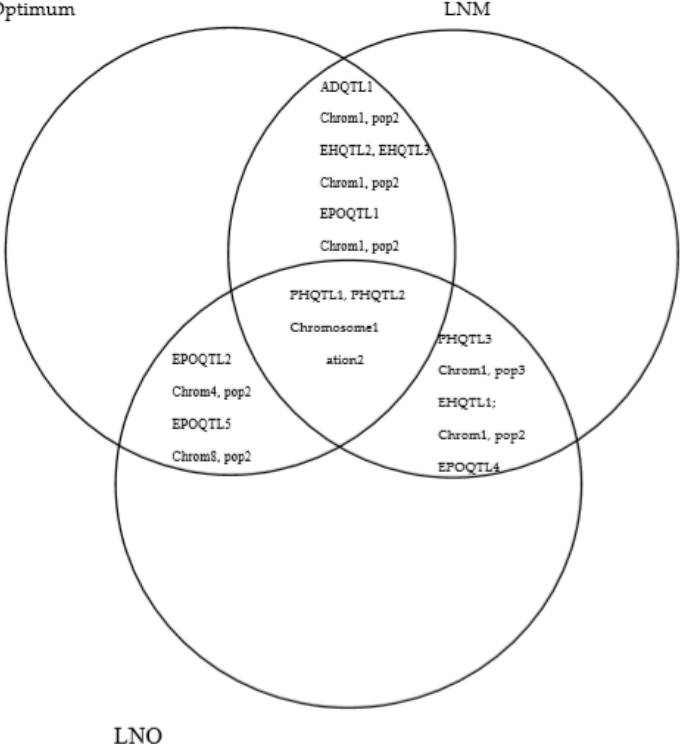
Figure 2. Overlapping QTLs between three field management conditions, and their chromosome locations in different populations.